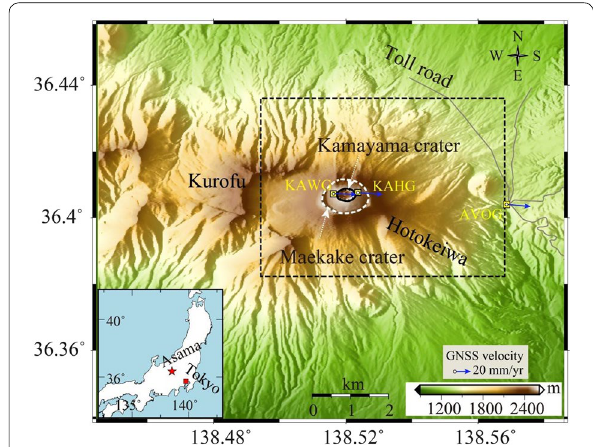
Fig. 1 The topography map of Asama volcano with an insert showing the locations of Mt. Asama and Tokyo. The white dashed line and black solid line on the summit indicate the Maekake and the Kamayama craters, respectively. Two old volcanoes, Kurofu and Hotokeiwa, lay to the west and on the southeast flank of Maekake volcano, respectively. The yellow squares indicate the location of the three GNSS stations, whereas the station AVOG is located at the eastern base of the volcano and the other two stations (KAWG and KAHG) are located on the edges of the summit Kamayama crater. The blue vectors indicate the horizontal displacement velocities of GNSS stations. The dashed black box indicates the region where our InSAR analysis focused on, namely, the geographical extents of Figs. 2, 5, 6, and